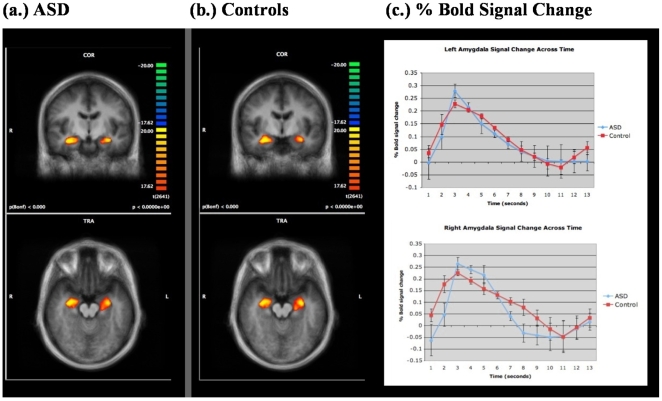
Amygdala activation during backward masking trials.Statistical maps of a priori regions of interest defined using the Talairach Atlas and superimposed on a composite average of 24 anatomical T1 image sets normalized to Talairach space. Note bilateral amygdala activation in both individuals with ASD (a.) and age-matched controls (b.) during the presentation of subthreshold anxious face stimuli. Images are presented according to radiological convention. Mean peristimulus plots of the average estimated hemodynamic responses to subthreshold anxious face images are shown (c.) for the right and left amygdala in individuals with ASD and controls. The control group is shown in red, and the ASD group is shown in blue.